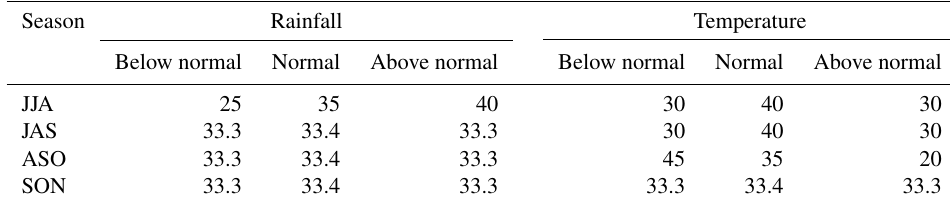
Table 2. IRI tercile seasonal forecast for the 2011 season. Season Rainfall Temperature Below normal Normal Above normal Below normal Normal Above normal JJA